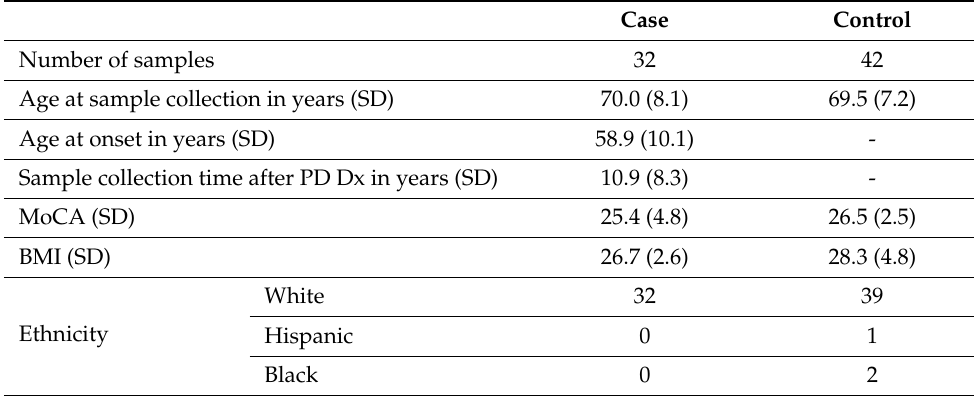
Table 1. Male LRRK2 patient sample